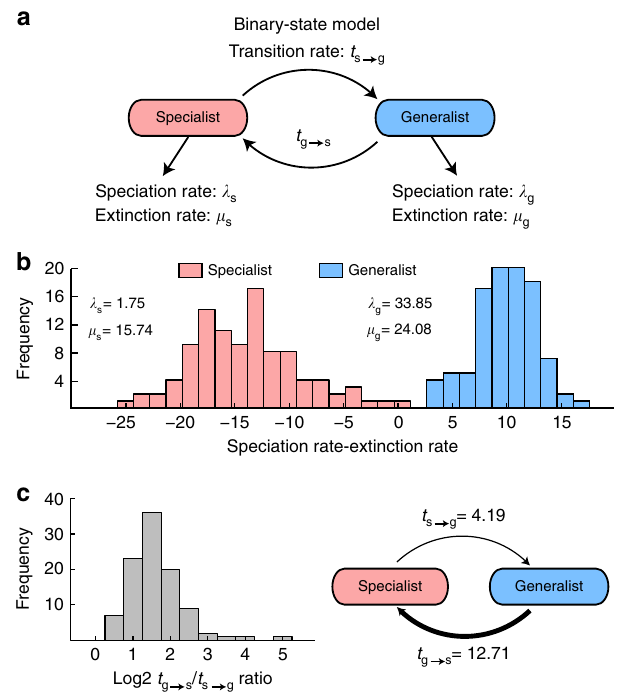
Fig. 3 Estimation of evolutionary characteristics for generalists and specialists. a Binary-state speciation and extinction (BiSSE) model for the evolution of specialists and generalists. Each state has distinct speciation ( λ ), extinction ( μ ), and state-transition ( t ) rates. b Generalists possess 19- fold higher speciation rates than specialists do. The net expansion rates (the differences between speciation and extinction rates) are positive for generalists and negative for specialists. Histogram data comes from 100 random subsamples (Methods). Average speciation and extinction rates for each state are indicated. c Generalists transform into specialists at three- fold faster rates than the reverse transitions. Histogram data come from 100 random subsamples (Methods). Average transition rates are